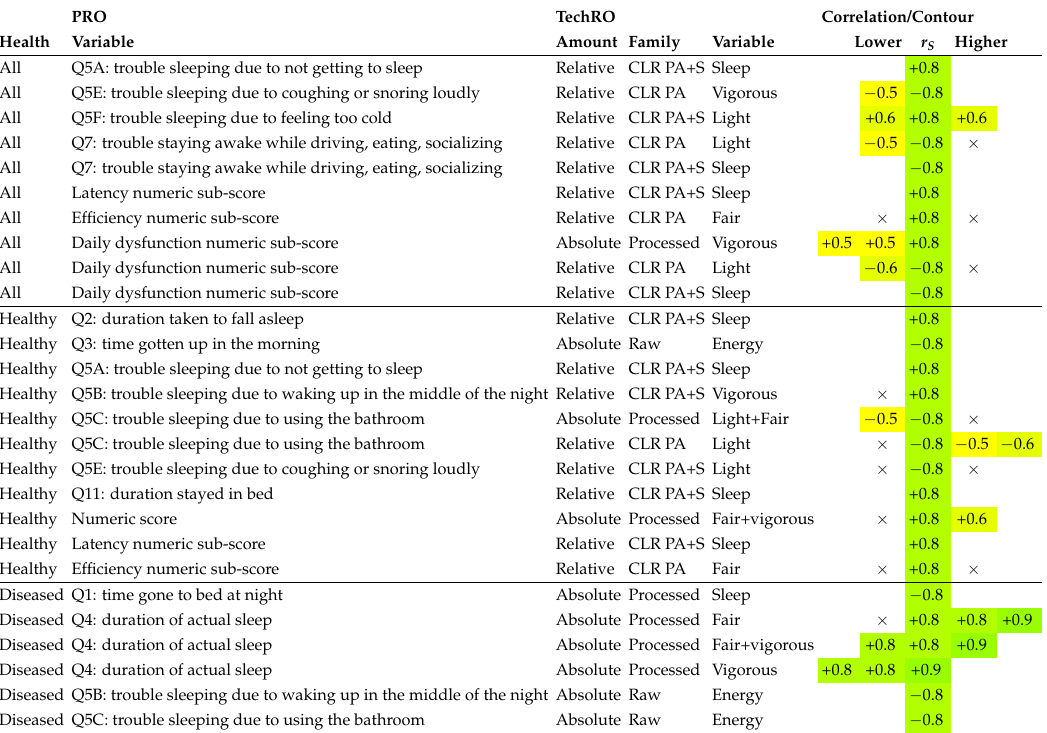
Table 13. Summary of found strong and significant Spearman rank correlations ( r S PROs of sleep (PSQI scale) and TechROs (Fitbit